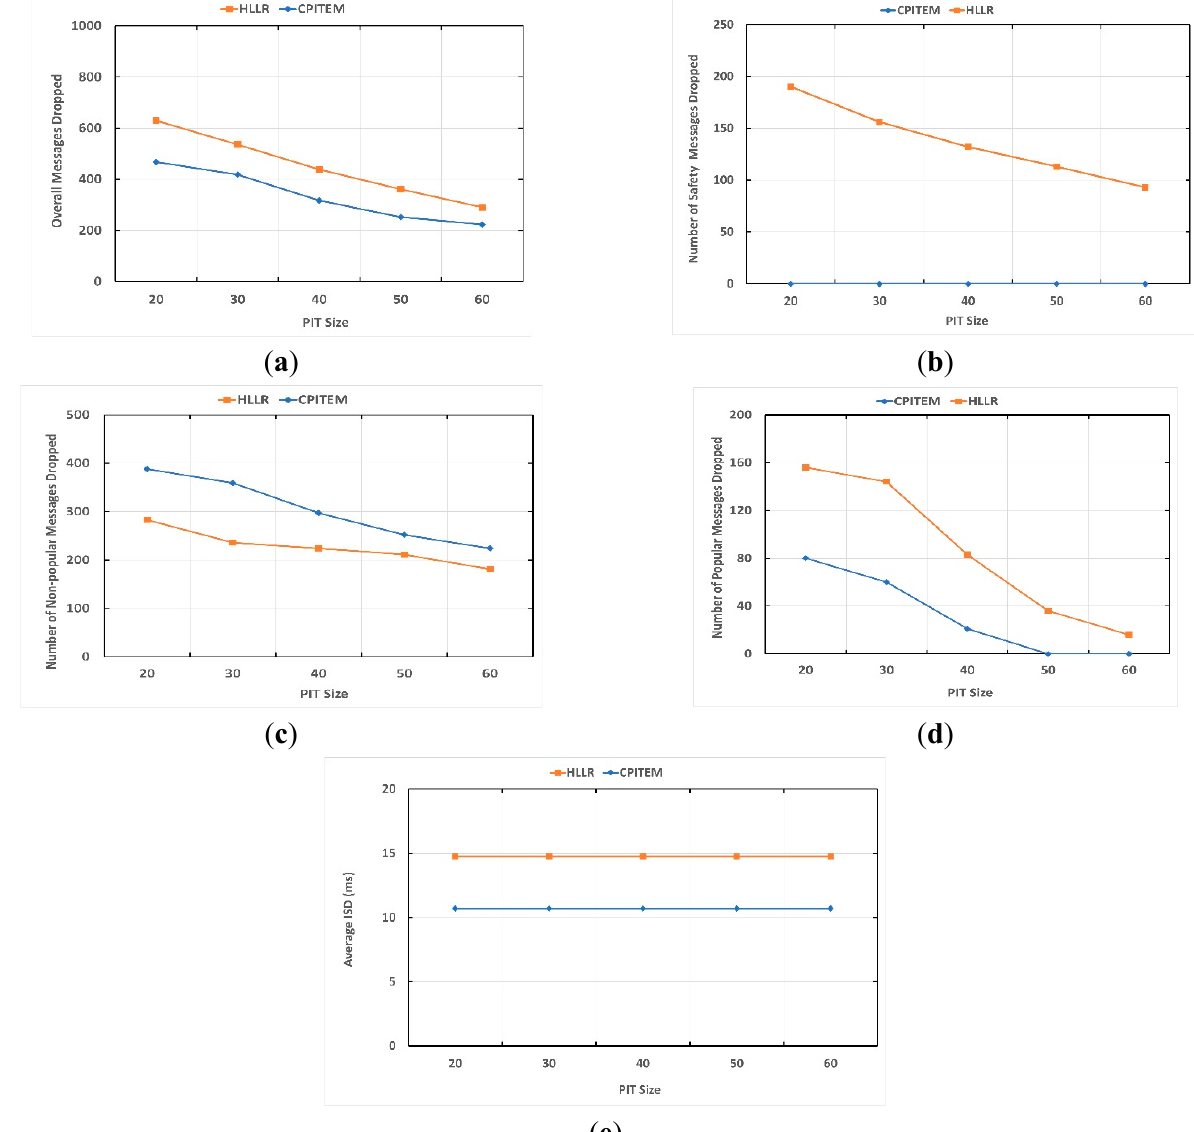
Figure 2. Experiment 2: Effect of PIT size. ( a ) Overall Interest messages dropped due to PIT size, ( b ) Interest messages related to safety dropped due to PIT size, ( c ) Interest messages related to non-popular, non-safety dropped due to PIT size, ( d ) Interest messages related to popular, non-safety content dropped due to PIT size, ( e ) average ISD.